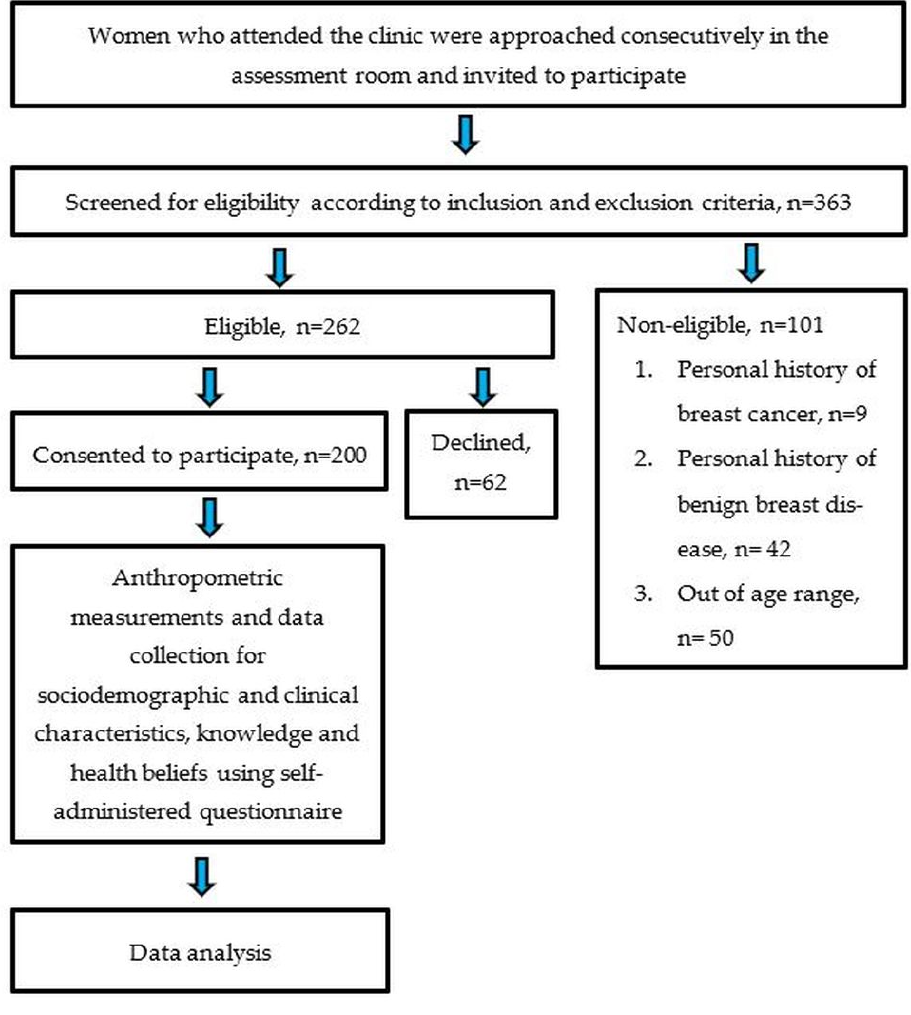
Figure 1. Flow chart of the study.